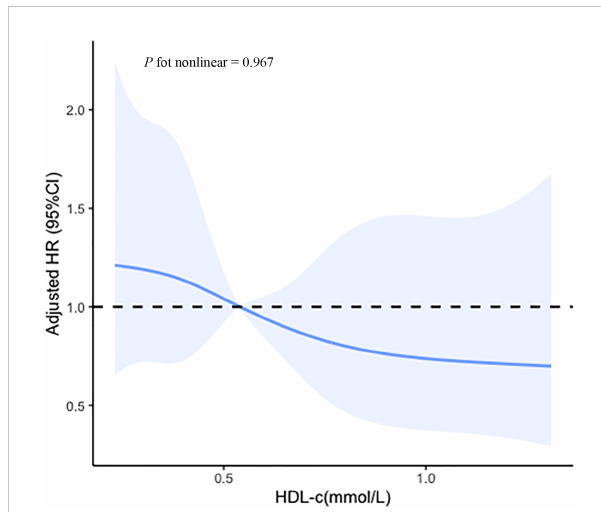
FIGURE 4 Cubic spline plot of the association between the HDL-c and the risk of mortality among sHLH patients. The solid lines and shading indicate the estimated hazard ratios and their corresponding 95% CIs. Analyses were adjusted for hemoglobin (HB), platelet (PLT), fi brinogen (Fib), and soluble IL-2 receptor (sCD25).